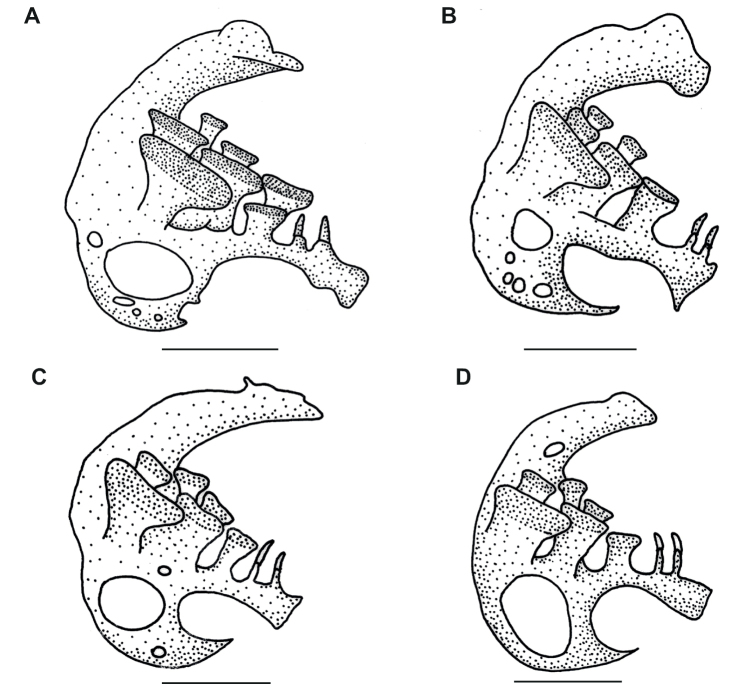
Comparison of the fifth ceratobranchial of A–CAmblypharyngodongrandisquamis and DA.melettinus. AWHT 11075, 64.2 mm SL BWHT 11046, 54.2 mm SL CWHT 11070, 40.0 mm SL DWHT 11072, 57.6 mm SL. Scale bar: 1 mm.